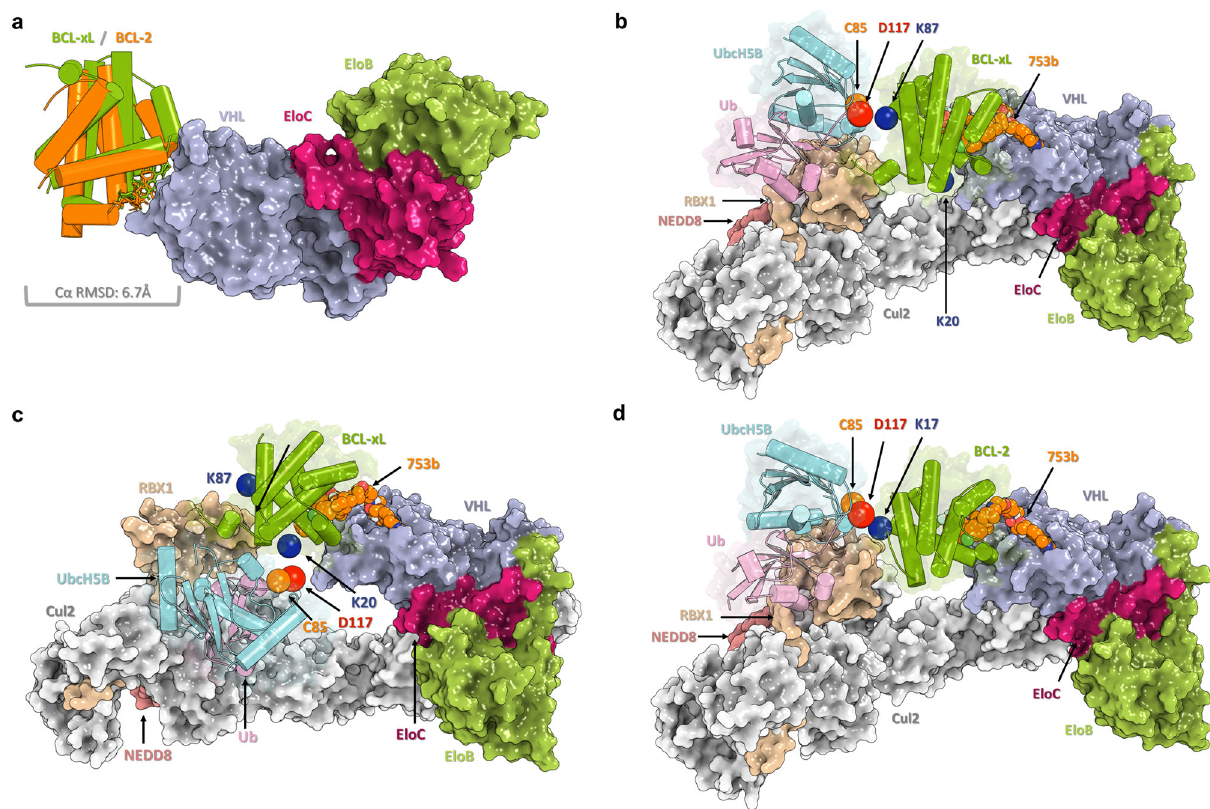
Fig. 6 Computational models of the CRL VHL /753b/BCL-xL/E2-Ub/RBX1 and CRL VHL /753b/BCL-2/E2-Ub/RBX1 complexes. a The superimposition of the modeled ternary complexes of VCB/753b/BCL-xL and VCB/753b/BCL-2. The C α RMSD of BCL-xL and BCL-2 is 6.7 Å. b The computational model of catalytic transition state of CRL VHL /753b/BCL-xL/UbcH5B-Ub/RBX1 with UbcH5B contacting with K87 of BCL-xL. The K87 of BCL-xL, C85, and D117 of UbcH5B are colored in blue, orange, and red, respectively. c The computational model of catalytic transition state of CRL VHL /753b/BCL-xL/UbcH5B-Ub/ RBX1 with UbcH5B contacting with K20 of BCL-xL. d The computational model of catalytic transition state of CRL VHL /753b/BCL-2/UbcH5B-Ub/RBX1 with UbcH5B contacting with K17 of